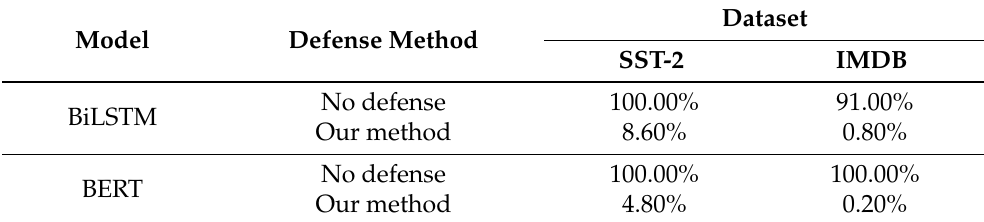
Table 5. Defense performance against sentence-level backdoor attack